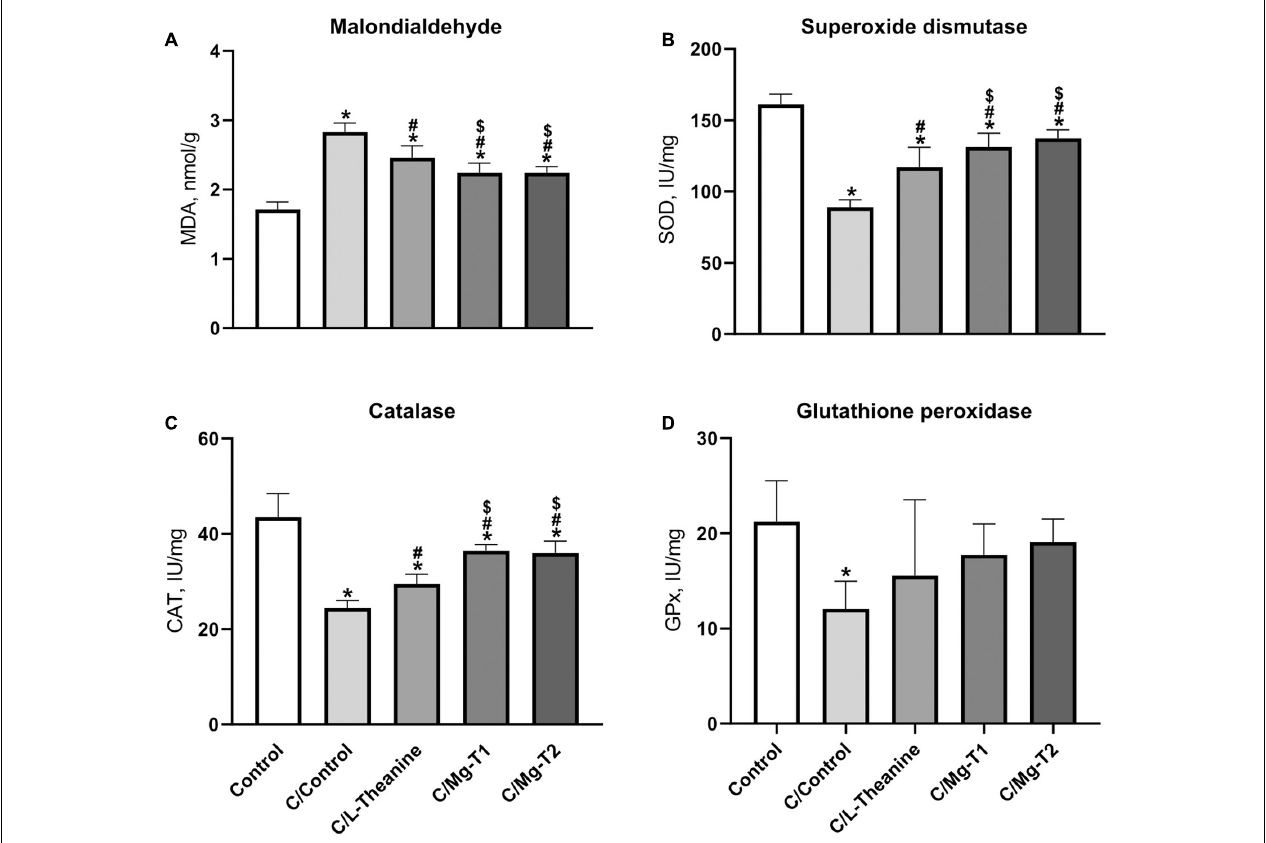
FIGURE 4 | L -Theanine and Mg- L -theanine compounds exhibit antioxidant effects. MDA (A) , SOD (B) , CAT (C) , and GPx (D) levels in the brain. One-way ANOVA with Tukey’s HSD was performed for multiple comparisons and values are represented as mean ± SD. * p < 0.05: compared to control, # p < 0.05: compared to caffeine control, $ p < 0.05: compared to L